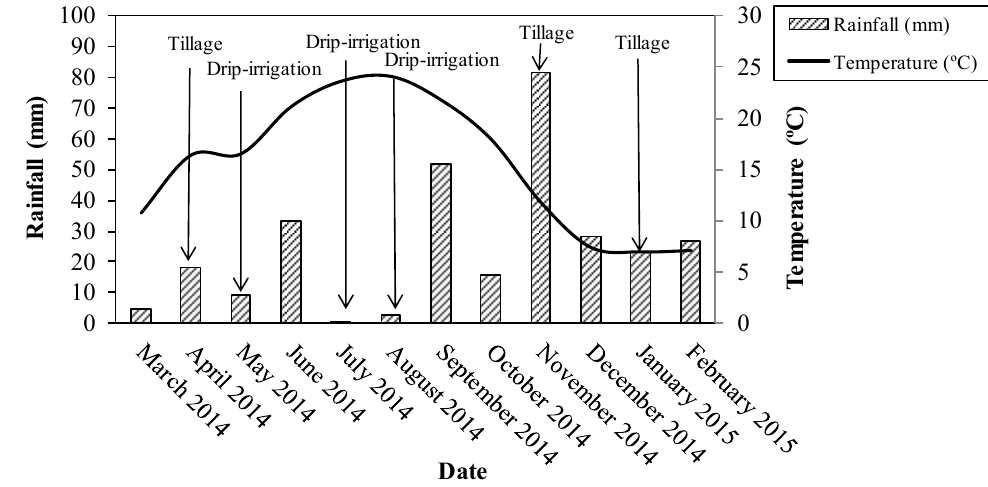
Figure 1. Mean monthly temperature and rainfall at the experimental site and the main agricultural practices carried out during the experimental period (March 2014–February 2015).